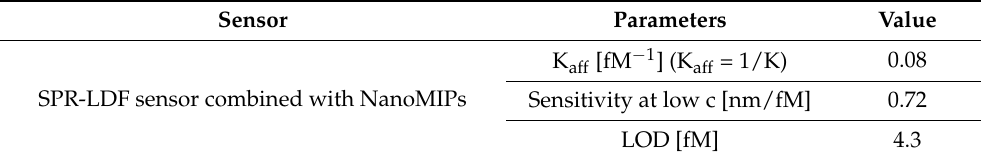
Table 2. Sensor’s chemical parameters for HTR detection in buffer